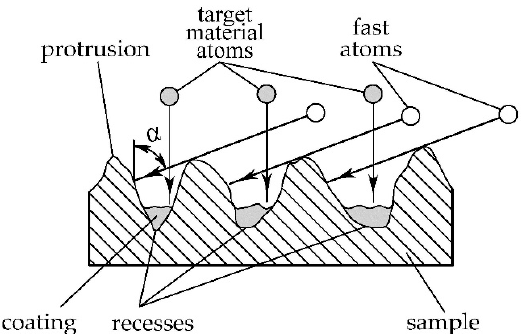
Figure 5. Scheme of sputtering by fast argon atoms of protrusions on a rough surface with simultaneous coating deposition. α —the angle of fast atoms incidence to the surface.